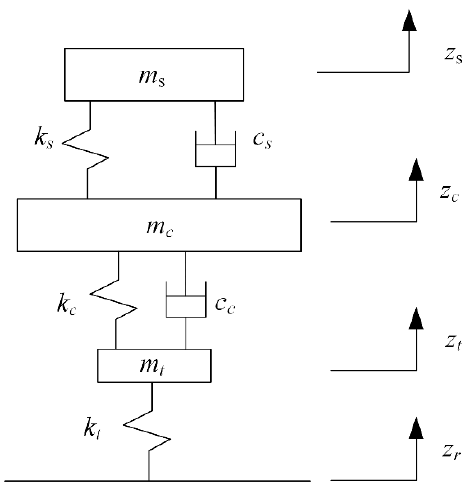
Figure 2. Three-degrees-of-freedom dynamic model of “ seat – body – tire ” system.